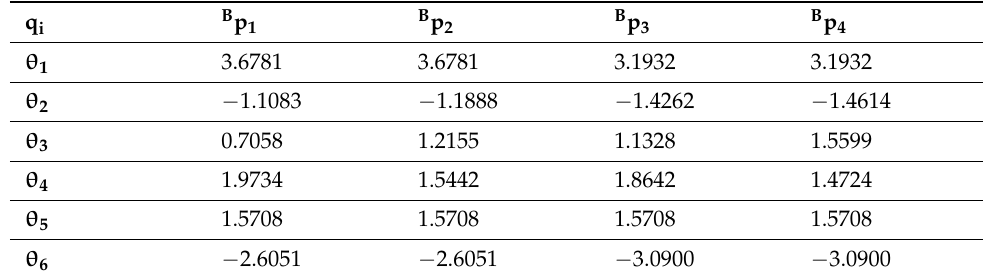
Table 3. “Bad” location (joint variables values) for the pick and place task (cylindrical